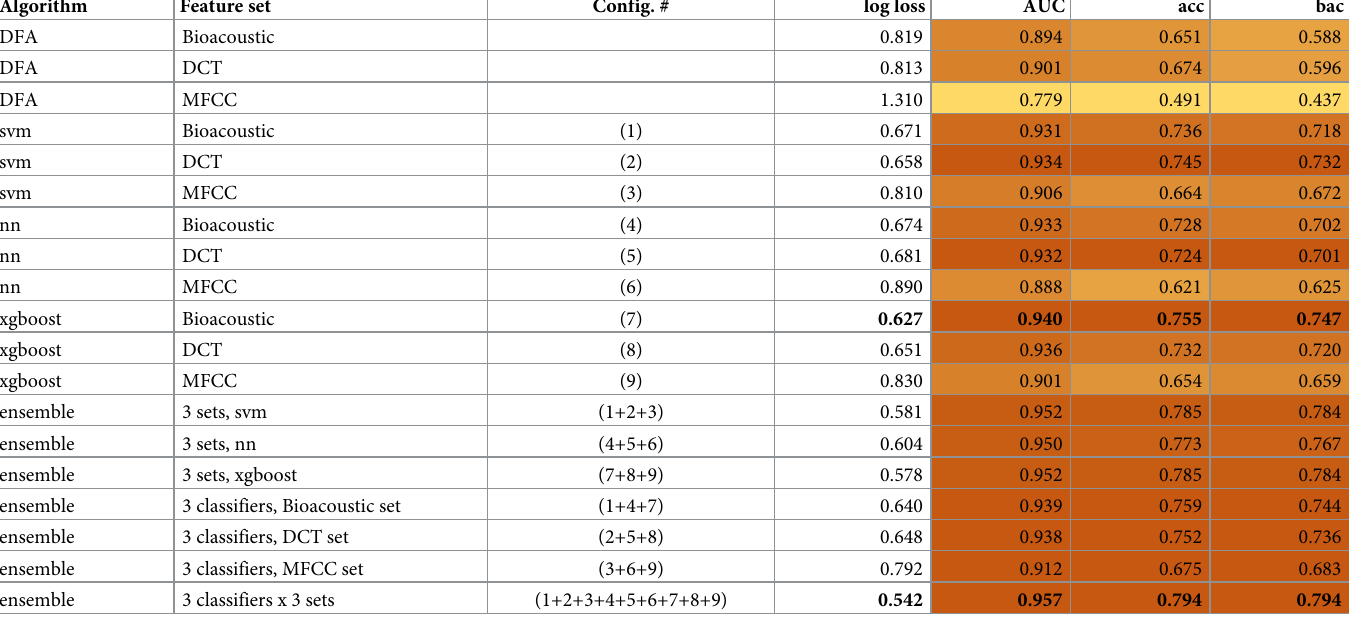
Table 2. Metrics characterizing the classification performance of call types as a function of the classifier and acoustic set used. Four metrics are reported: log loss, AUC, balanced accuracy, and accuracy. The best performance achieved by a primary configuration (upper part) and an ensemble configuration (lower part) is displayed in bold. For AUC, accuracy (acc) and balanced accuracy (bac), a color scale highlights the progression from the lowest scores (in pale orange) to the highest scores (in dark orange) in the column.